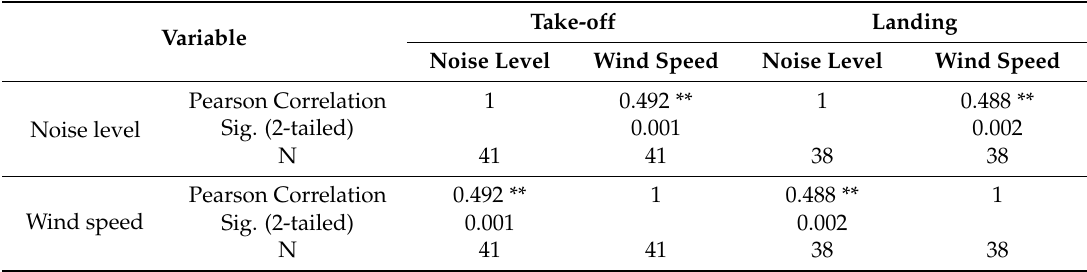
Table 11. The regression of climate toward noise level at take off and